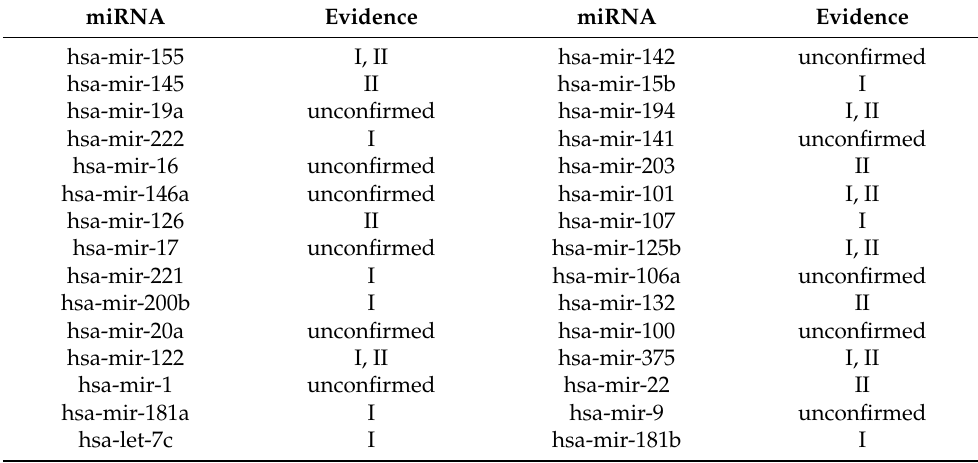
Table 3. The top 30 liver cancer-related miRNAs predicted by the RNSSLFN model. (Column 1: top 1–15 miRNA names; Column 3: top 16–30 miRNA names. I and II represent the association between the miRNA and liver cancer, which has been verified by the databases dbDEMC and miRCancer, respectively).